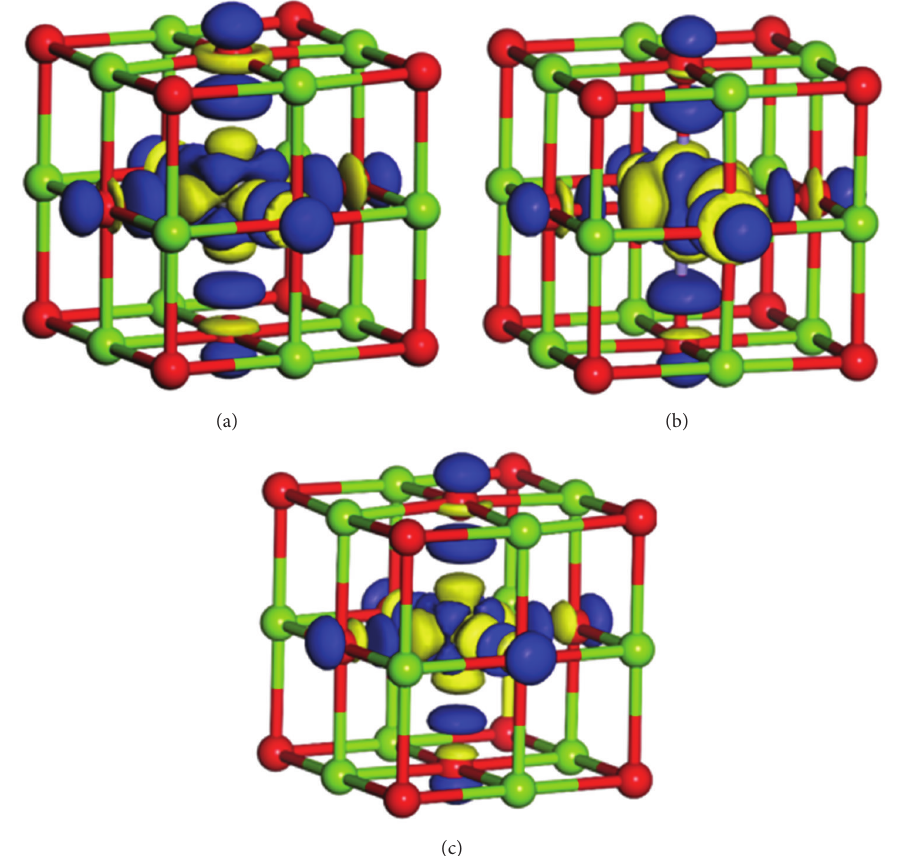
Figure 2: EDD for the V (a), Fe (b), and Ni (c) doped MgO(100) surfaces. The blue region corresponds to a density gain and the yellow region to a density loss. Oxygen atoms in red balls and metal atoms in green balls. For a better overview, only a 1 × 1 × 1 cell was used.